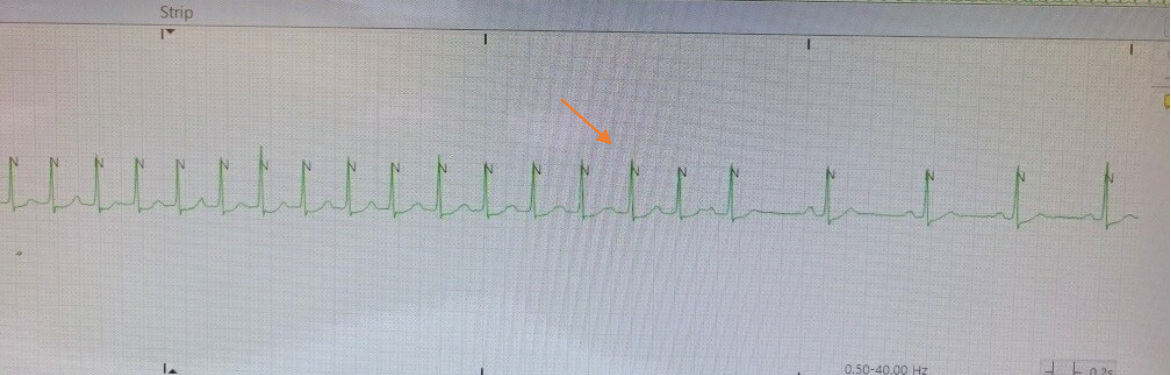
Figure 2. Telemetry strip showing resumption of normal sinus rhythm in the middle of the tracing at a rate of 126 bpm. The arrow draw attention to the cool down phenomenon before termination.